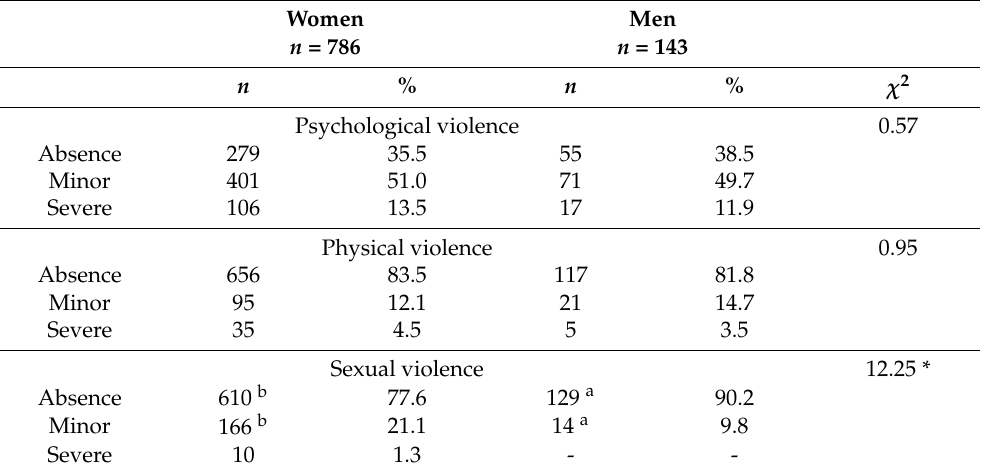
Table 1. Gender Differences in Severity of